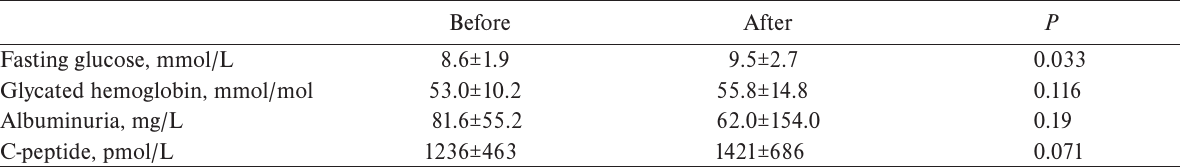
Table 2. Changes in glucose metabolism at 12 months in diabetes subgroup, n=25 (49%).